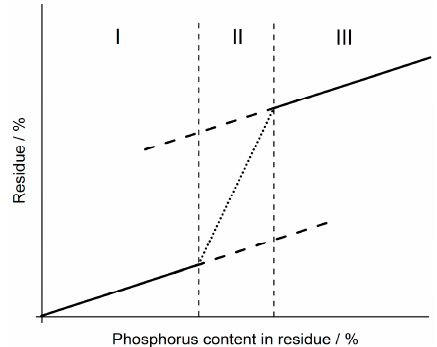
Figure 11. Proposed progression of residue formation with increasing phosphorus in the residue. The curve is divided into: an approximately linear phosphorus-residue relation (I); an area of inflection of the curve (II); and a continuous increase of residue with phosphorus content after the inflection point (III) [45].